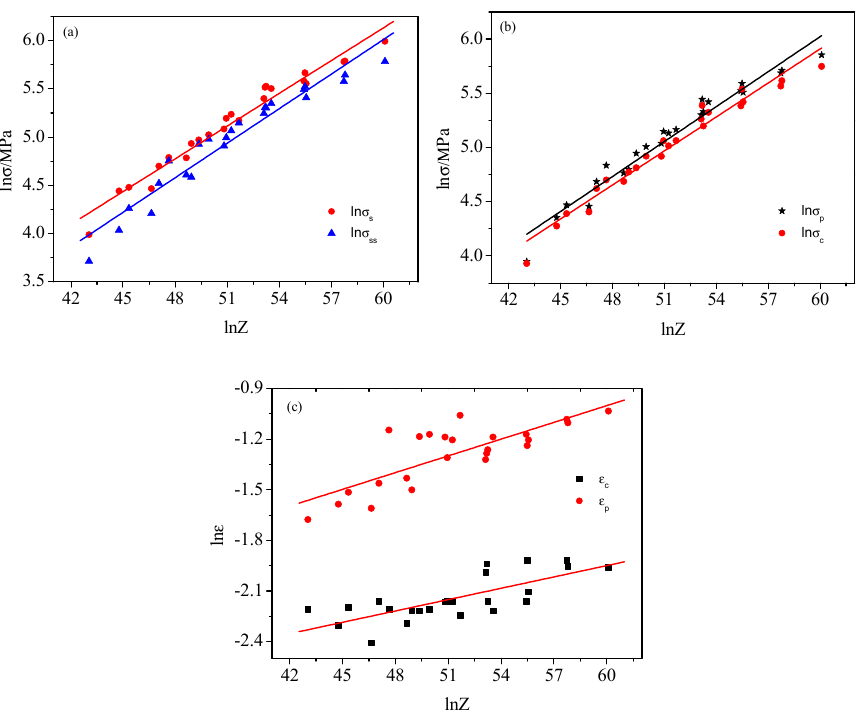
Figure 8. Dependence of mechanical parameters on Zener–Hollomon parameter.